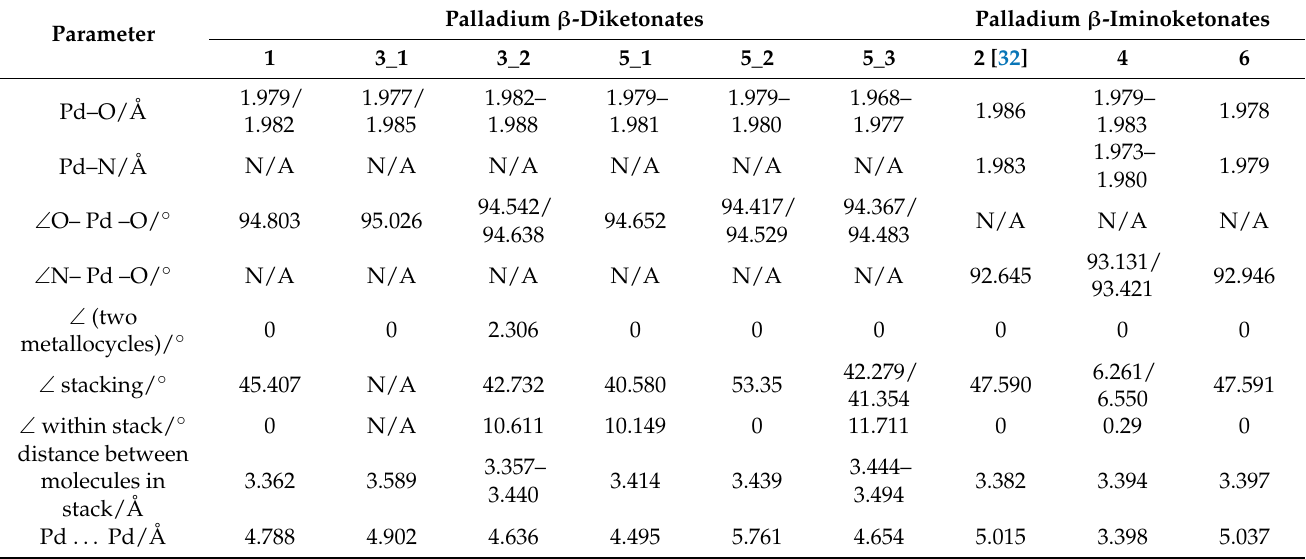
Table 4. Bond lengths and angles of [Pd(CH 3 CXCHCO(R)) 2 ] complexes.